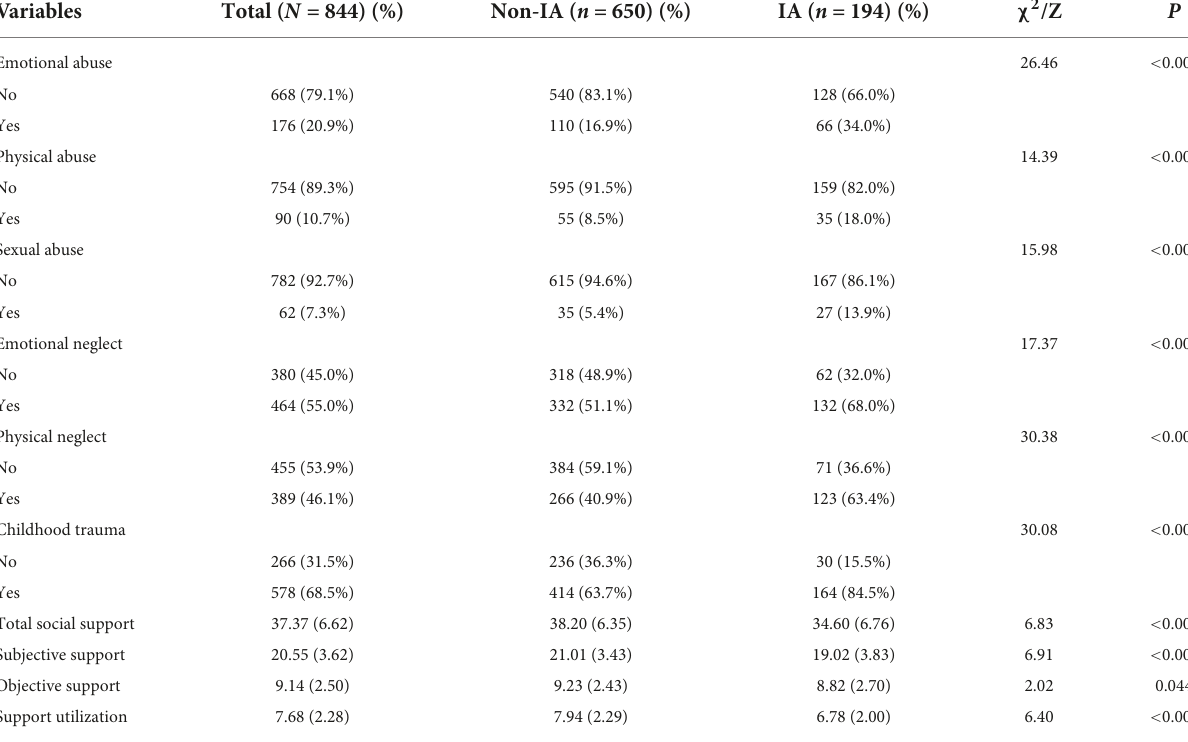
TABLE 2 Comparison of childhood trauma and social support scale between the Internet addiction group and the non-Internet addiction group. Variables